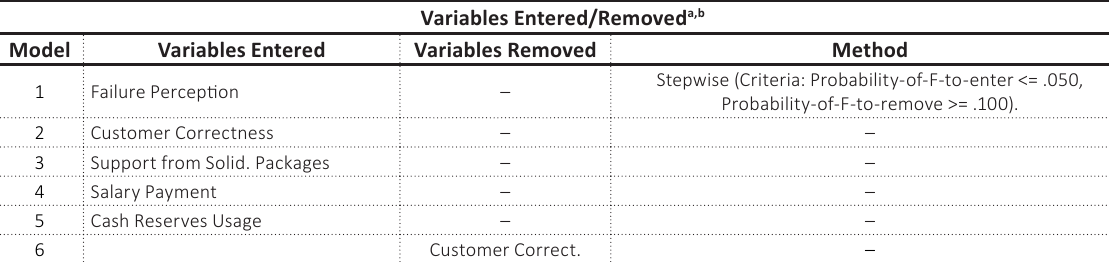
Table 5. The selection of significant variables by F